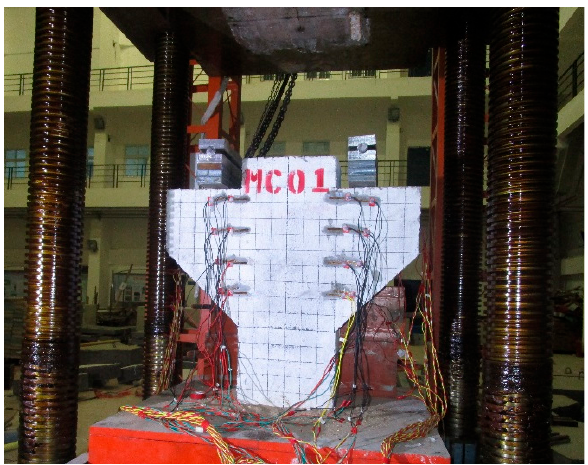
Figure 4. Test loading device for corbel specimens.